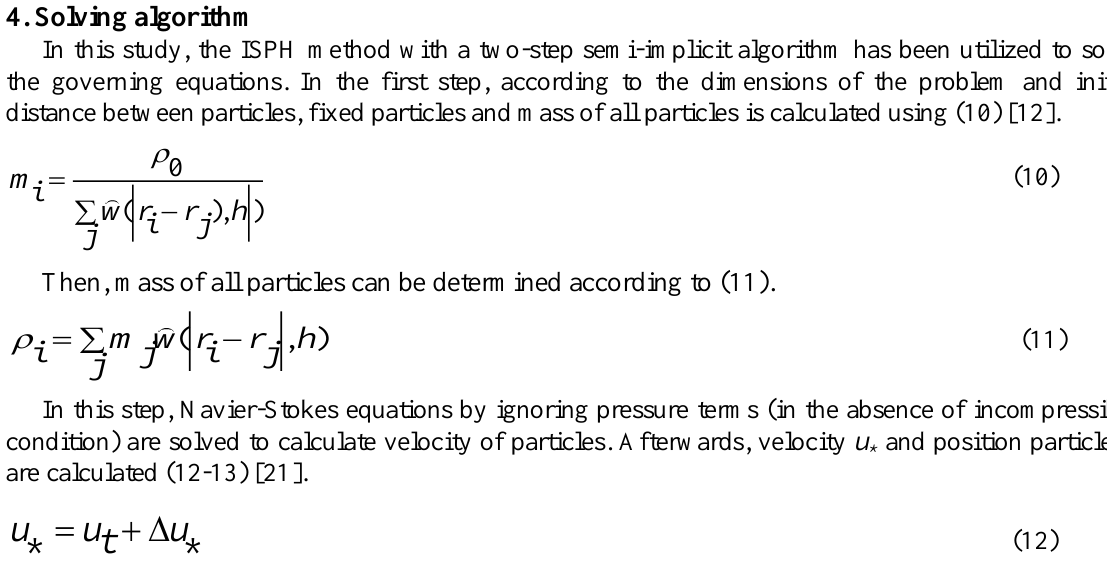
Figure 1 Dividing of the Computational domain into squares with 2h sizes for finding particles in the influence domain of the central